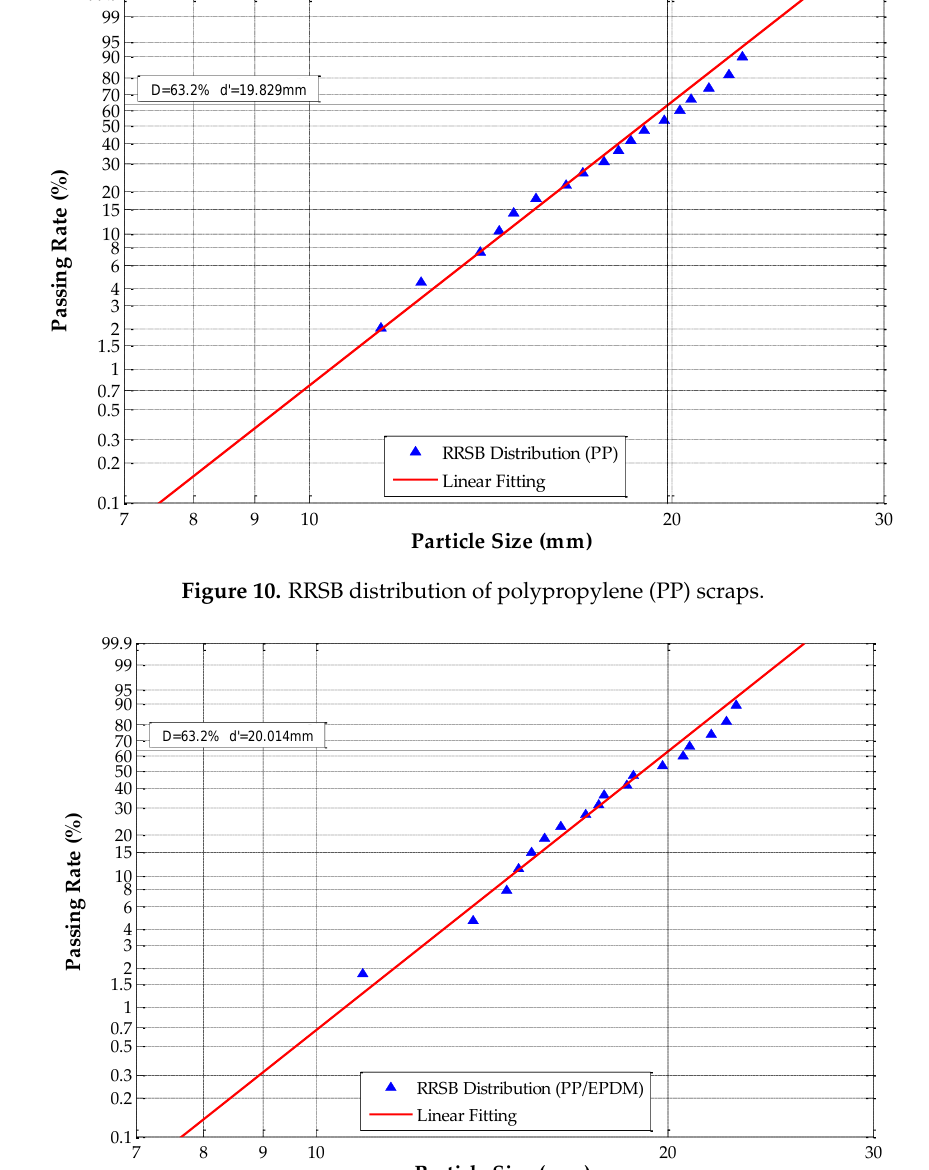
Figure 9. RRSB distribution of acrylonitrile-butadiene-styrene/polycarbonate (ABS/PC) samples.